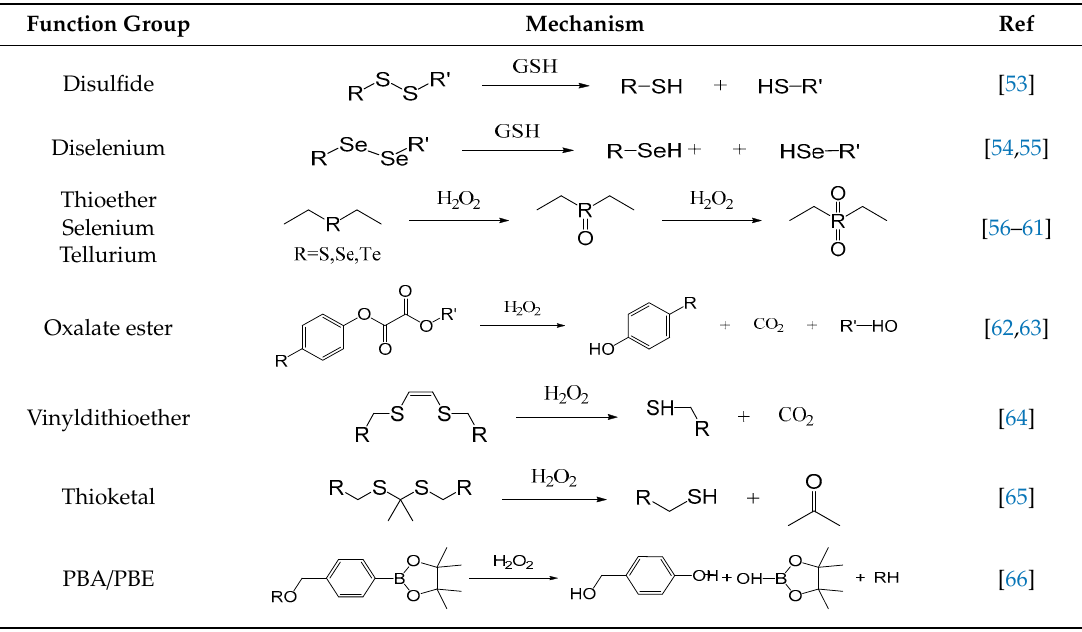
Table 2. Chemical structures for redox-responsive systems.